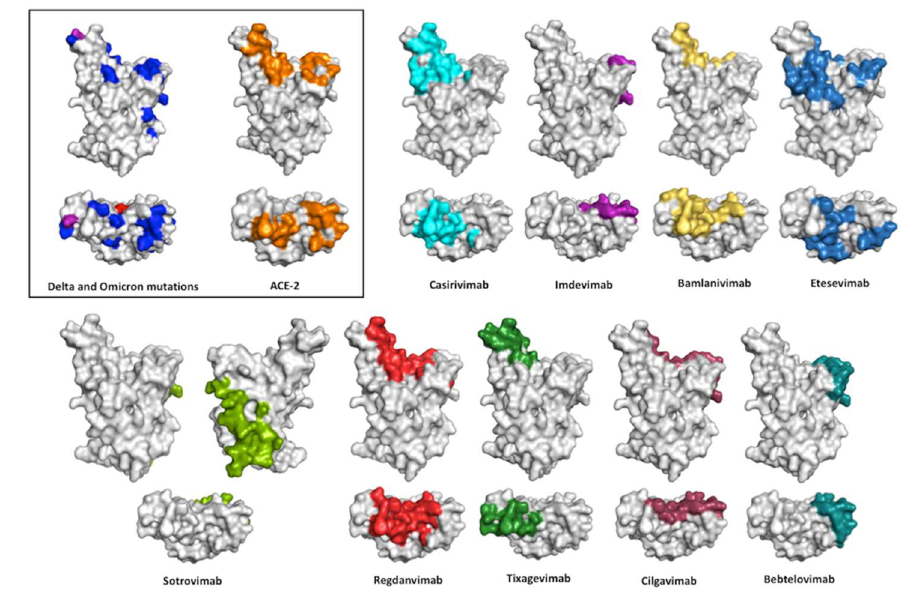
Figure 6. Conolly surface of SARS-CoV-2 RBD in the same view of Figure 3 showing the interface with ACE-2 and the epitopes recognized by the anti-SARS-CoV-2 therapeutic antibodies. Front and top view of the structural surface of the SARS-CoV-2 RBD shows the location of the Delta variant mutations (in red), Omicron variant mutations (in blue), and mutations in both variants (in purple). RBD residues that contact ACE-2 are indicated in orange, whereas the RBD residues protected by anti–SARS-CoV2 antibodies are indicated with different colors: Casirivimab (cyan); Imdevimab (purple); Bamlanivimab (yellow); Etesevimab (marine blue); Sotrovimab (green); Regdanvimab (red); Tixagevimab (forest green); Cilgavimab (raspberry); and Bebtelovimab (deep teal) PDB 7MZG. The figures were prepared using PyMOL Molecular Graphics System version 2.4.1. Schrödinger, LLC, New York (https://pymol.org/2, accessed on 16 May